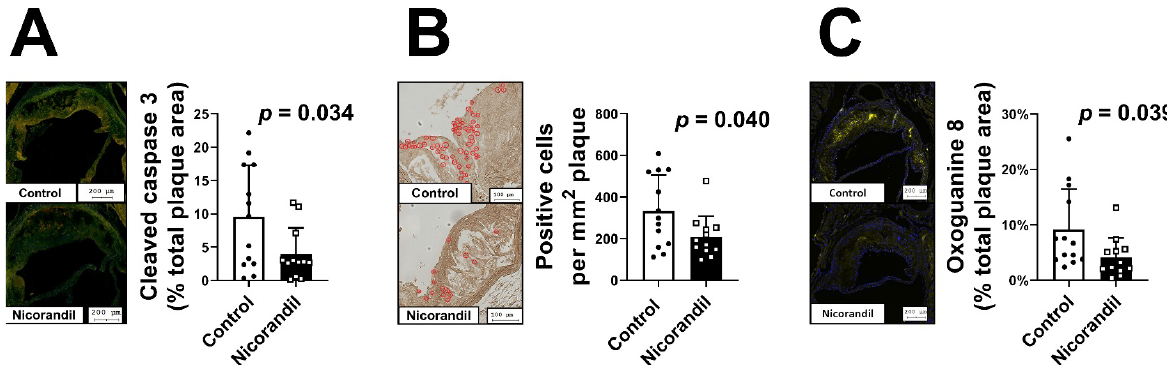
Figure 5. Effect of nicorandil treatment on apoptosis in vivo. Atherosclerotic plaque formation was induced by a high-fat diet in 25 LDL-R -/- mice. The animals were randomized to either a control group ( n = 13) or a nicorandil treatment group ( n = 12, 10 mg/kg/day). Nicorandil treatment led to a significantly decreased cleaved caspase-3 content ( A ), a significantly lower number of apoptotic nuclei ( B ), and decreased expression of oxidative DNA damage ( C ). All values given represent means ± standard deviations; the statistical significance of p ≤ 0.05 was considered significant.